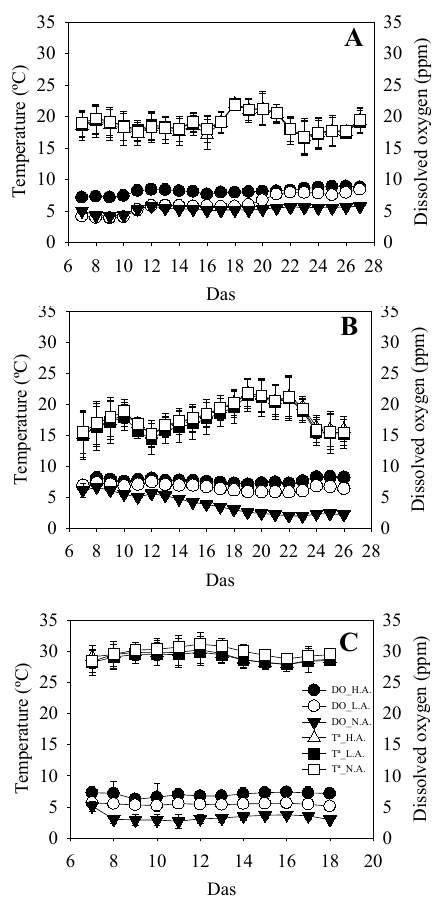
Fig. 1. Evolution of dissolved oxygen (DO) and temperature (Tª) of the nutrient solution under different levels of aeration (no aeration -NA-, low aeration-LA-, high aeration -HA-) in three different growing cycles (autumn -A-, winter -B-, summer -C-). Each datum point for each day after sowing (Das) is the average of 24 hourly measurements (n =